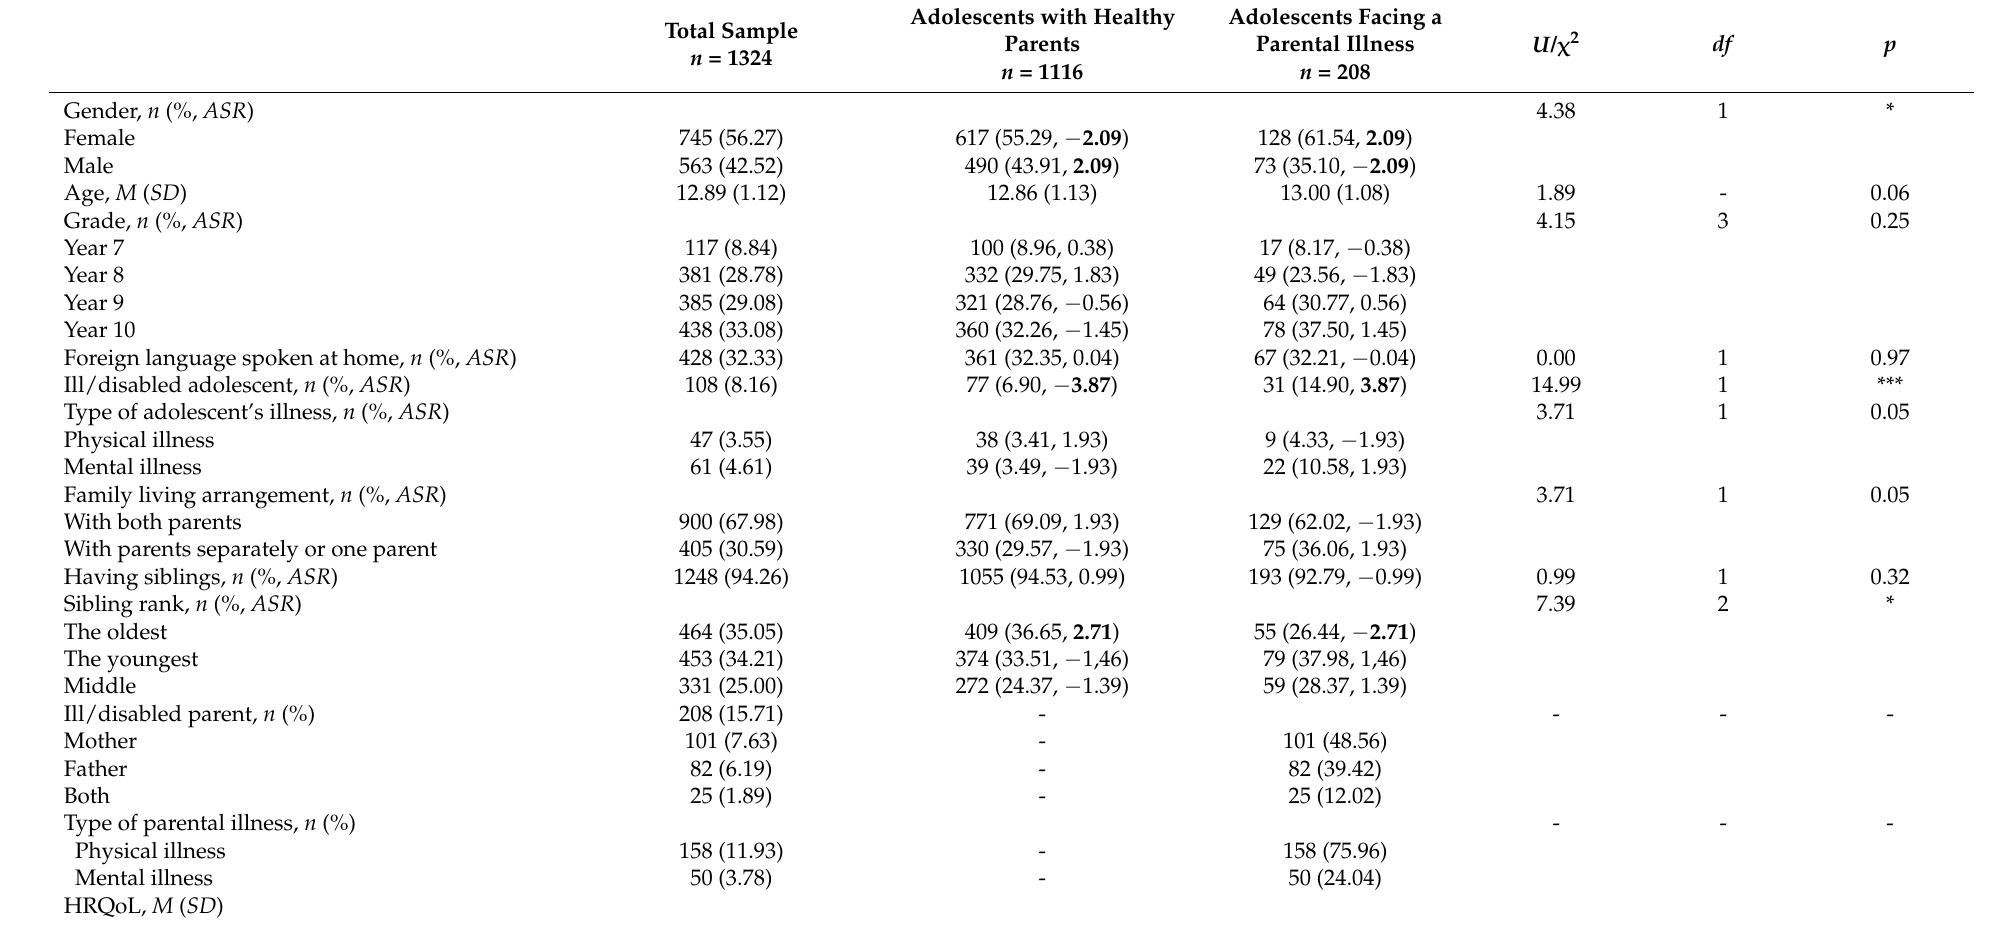
Table 1. Characteristics of the Total Sample and Characteristics of Adolescents with Healthy Parents compared with Adolescents Facing a Parental